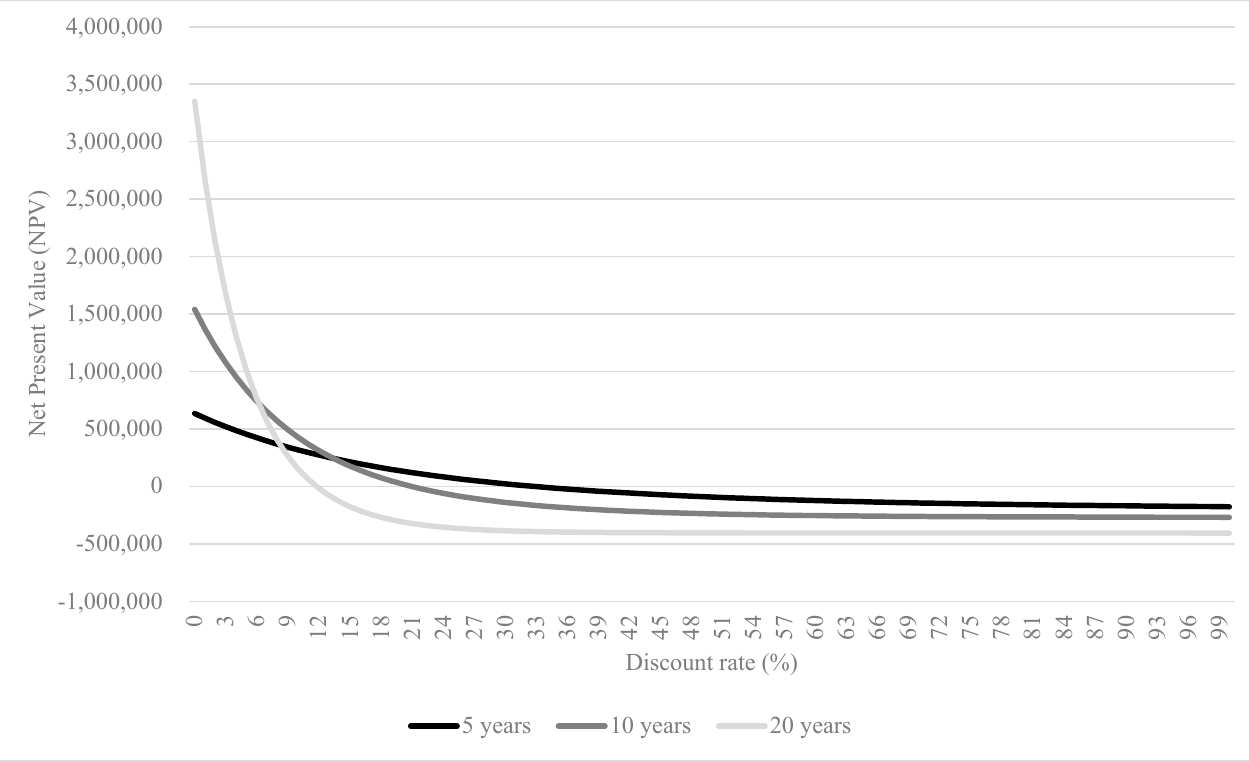
Figure 5. NPV graph according to the change in the discount rate (1000 KRW).